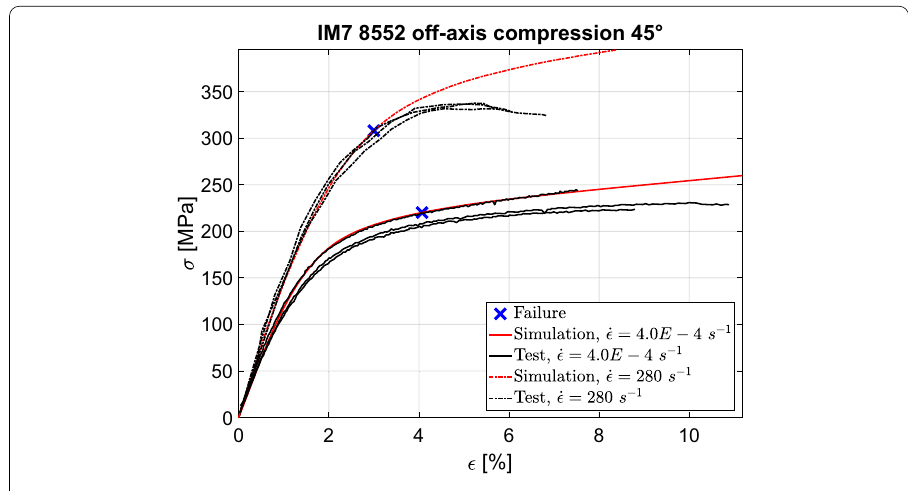
Fig. 18 True stress–true strain curves for the compression tests and simulations, 45 ◦